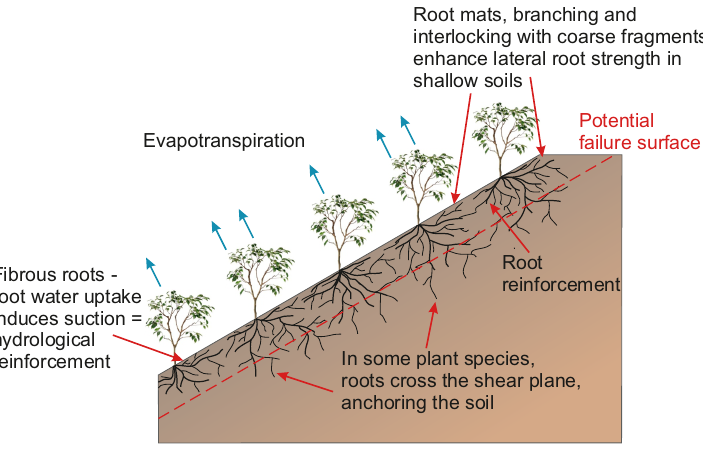
Figure 1. Root reinforcement in slope stability (inspired from